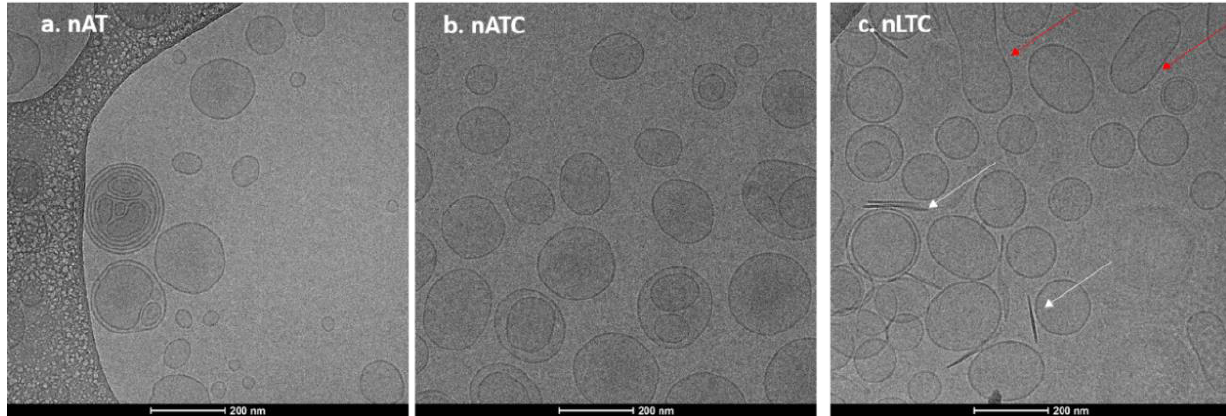
length rods, probably CUR crystals expulsed from nLTC (90–200 nm nanovesicles) lipid bilayers. All nanovesicles were mostly unilamellar. bilayers. All nanovesicles were mostly unilamellar.